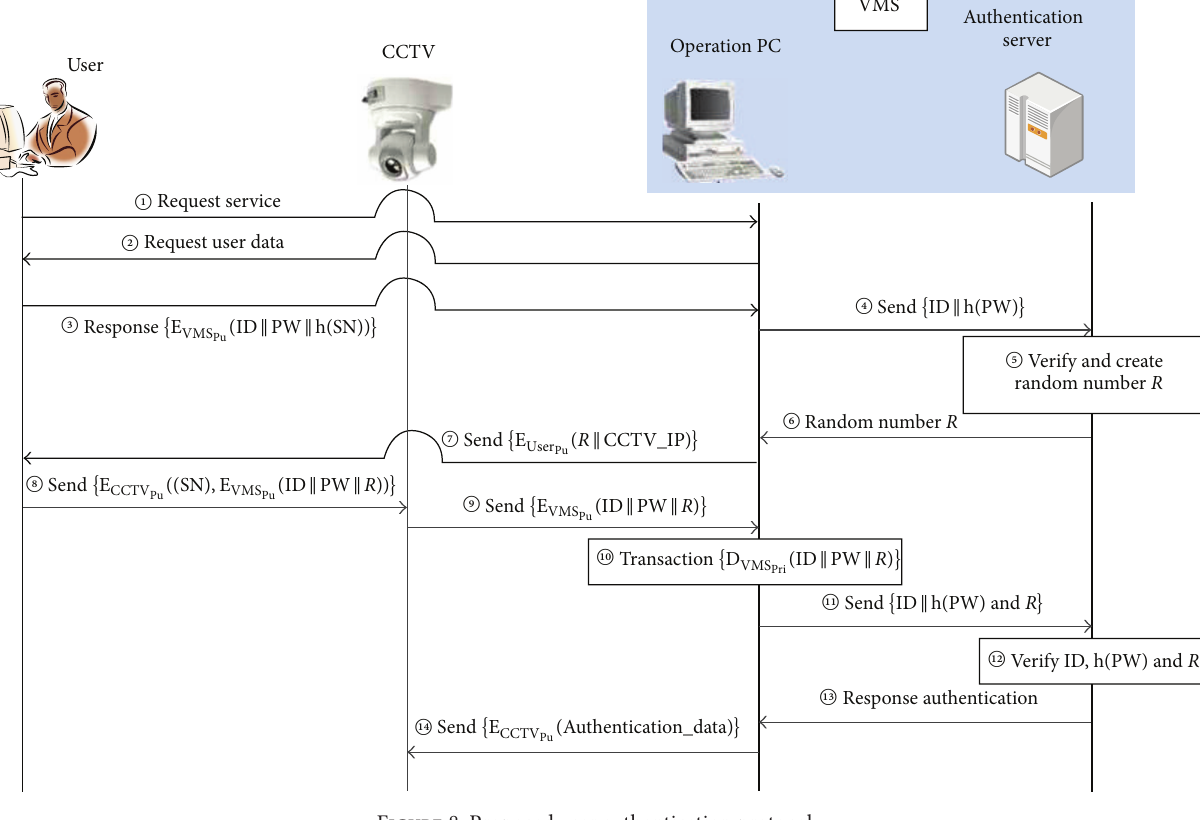
Figure 8: Proposed user authentication